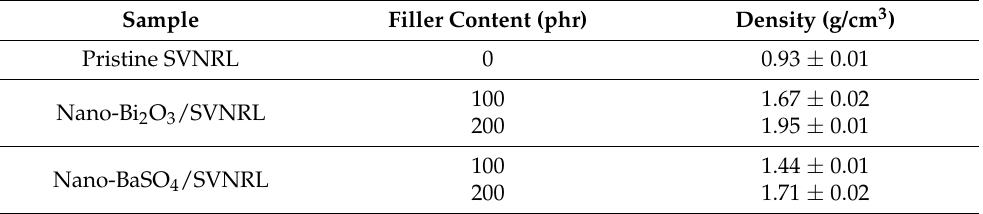
Table 2. Densities of pristine SVNRL, nano-Bi 2 O 3 /SVNRL, and nano-BaSO 4 /SVNRL composites containing filler content of 0, 100 phr, and 200 phr.